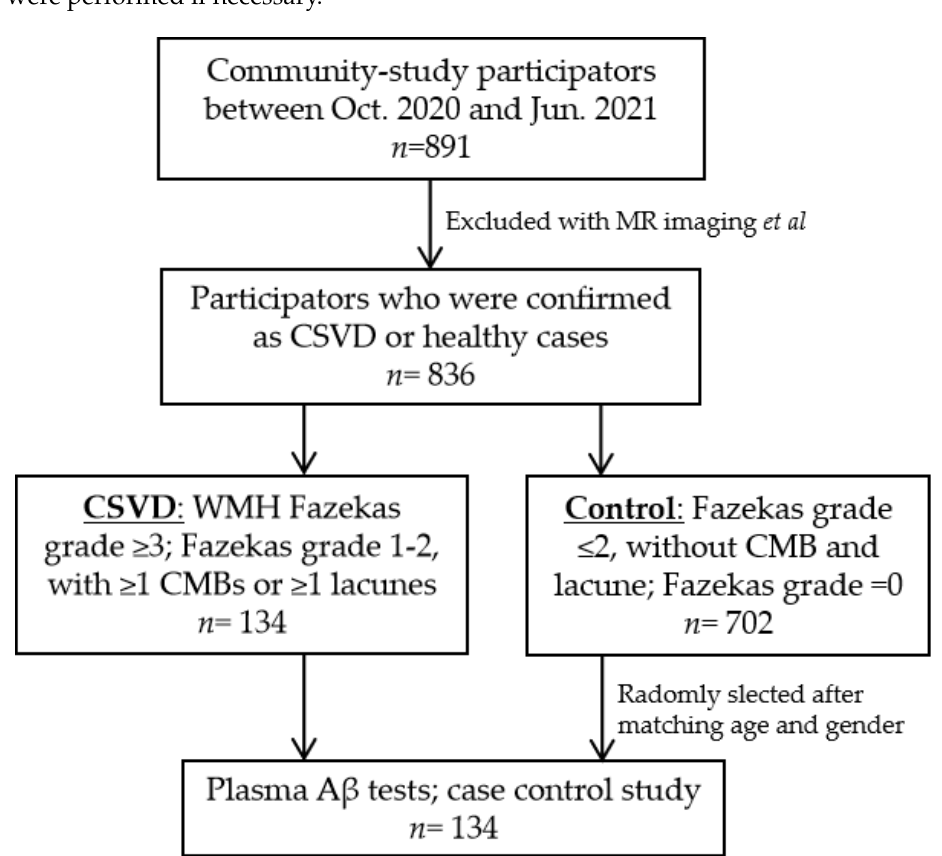
Figure 1. Flow chart for enrollment of participants.